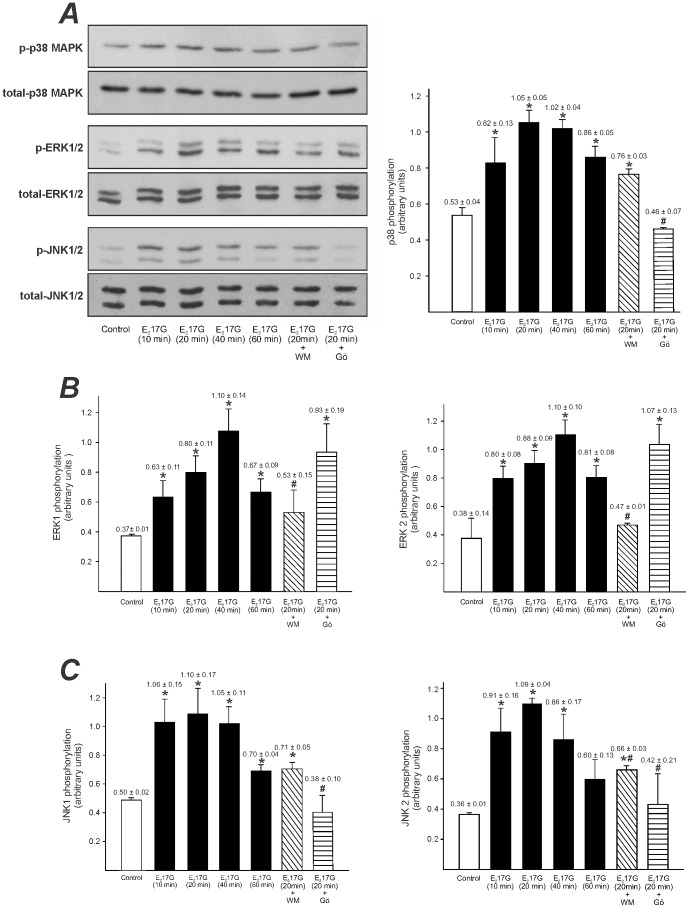
E217G activates the MAPK signalling pathway.
(A) left panel: representative Western blottings of phospho (p)-p38, p-ERK1/2, p-JNK1/2 and total forms of all these MAPK types were obtained from whole cellular lysates of primary-cultured rat hepatocytes incubated with E217G (200 µM) for 10 to 60 min, or with E217G (200 µM) for 20 min in cells pretreated with the PI3K inhibitor wortmanin (WM, 100 nM) or with the cPKC inhibitor Gö6976 (Gö, 1 µM) for 15 min. A (right panel), and B and C panels show phosphorylation status of all MAPK types evaluated (calculated as the p-MAPK to total MAPK ratio for each experimental condition). An arbitrary value of 100 was assigned to the band of highest densitometric intensity in every Western blot before the ratio was calculated. The results are shown as mean ± SEM (n = 5). *P<0.05 vs. control (cells treated only with DMSO), and #P<0.05 vs. E217G (20 min).